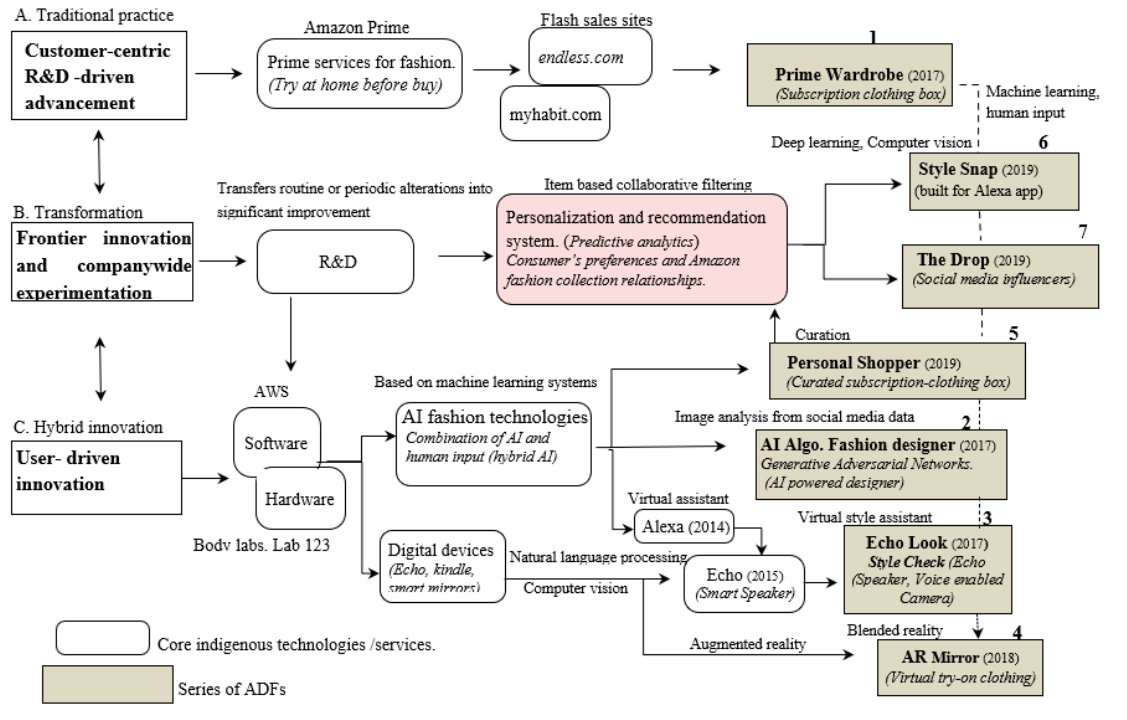
Figure 11. Amazon’s ADFs development by learning from preceding innovations. Source: Authors’ elaboration based on [10].